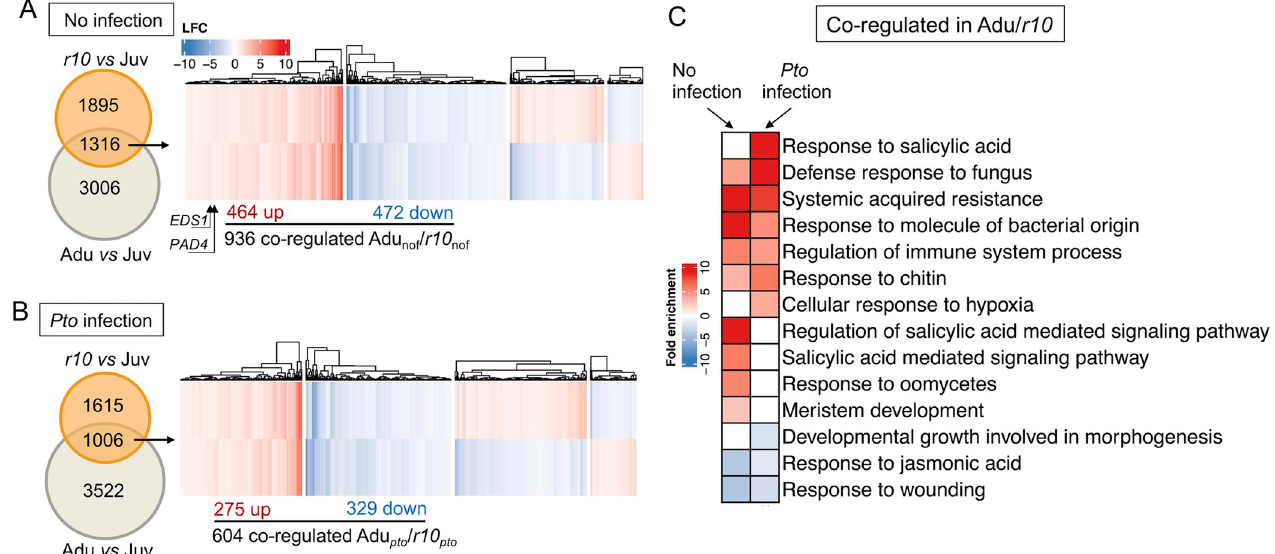
Fig 4. rSPL10 transcriptomes resembled that of adult leaves. A , an expression profiling of co-regulated DEGs by adult and rSPL10 leaves at non-infected state compared with juvenile leaves. EDS1 and PAD4 were identified as Adu/ r10 co-upregulated DEGs under non-infected state, which are indicated in the heatmap with arrows. B , expressing profiles of co-regulated DEGs by adult and rSPL10 from Adu- P or r10 - P against Juv- P . For the clustered heatmaps in 4 A and B, blue represents down-regulated DEGs and red is for up-regulated DEGs. Euclidean distance was used for calculating distance in the partition around medoids (PAM) clustering (k = 4). C , GO enrichment of co-regulated adult and r10 vs juvenile DEGs in non-infected and Pto -infection states.